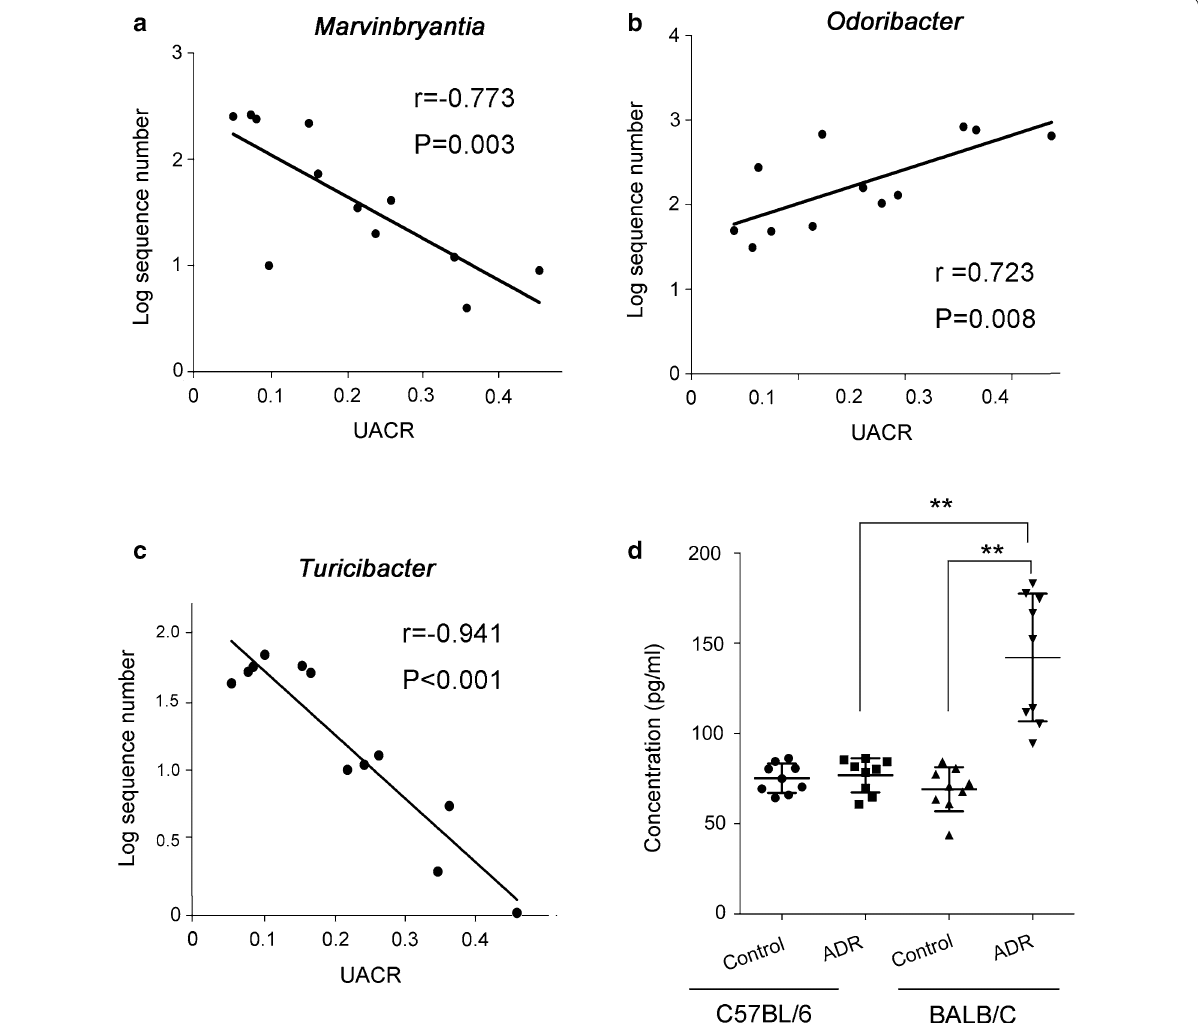
Fig. 4 The association between the microbiomes and the UACR. a The association between the Marvinbryantia and the UACR. b The association between the Odoribacter and the UACR. c The association between the Turicibacter and the UACR. d The serum IL-2 concentrations of the four